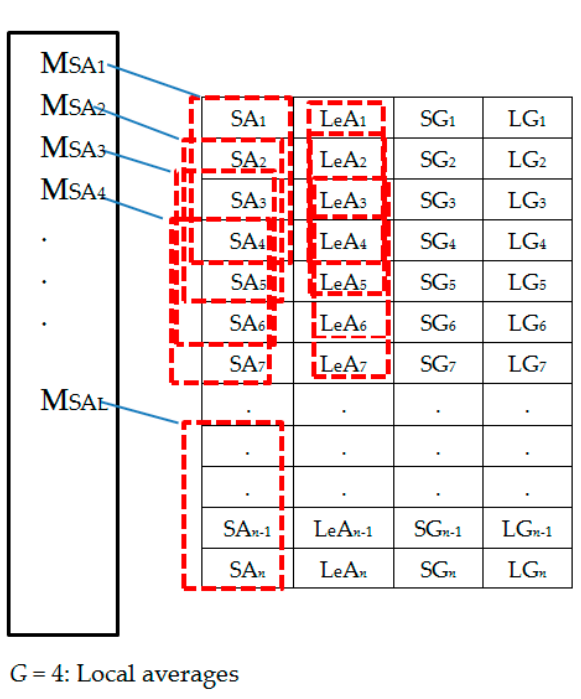
Figure 7. Set 1: Generating local averages.